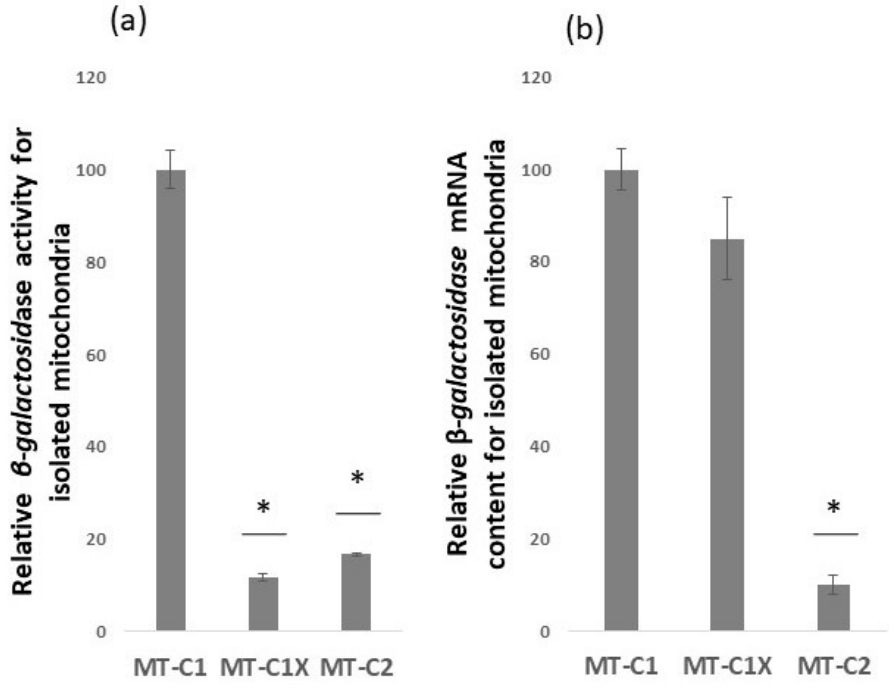
Figure 3. Analysis of relative β -galactosidase activities and relative mRNA content of isolated mito- chondria. ( a ) β -galactosidase activity of isolated mitochondria is highly reduced in the absence of COX2 mitochondrial translation initiation signal MT-C1X in comparison to the MT-C1 construct that con- tains the translation initiation signal. ( b ) To relate β -galactosidase activity to translation level, mRNA content of the constructs was compared via RT-qPCR analysis. The result showed similar levels of β -galactosidase mRNA for MT-C1 and MT-C1X, whereas the MT-C2 mRNA level was significantly lower, possibly in the absence of the OXA1 3 (cid:48) -UTR sequence. Error bars represent standard deviation. * Represents statistically significant results compared to the MT-C1. t -test analysis ( p -value ≤ 0.05) was used to compare